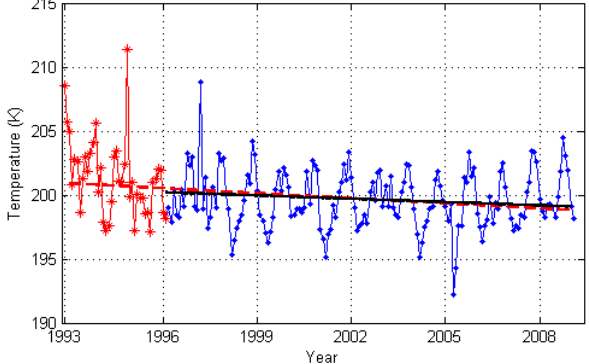
Figure 5: Time evolution of the monthly averaged temperature values in the lower 4 Fig. 5. Time evolution of the monthly averaged temperature values stratosphere (18-19 km) with the post-Pinatubo data (red star line) and the without post-5 in the lower stratosphere (18–19km) with the post-Pinatubo data Pinatubo data (blue line). The superimposed cooling trend line obtained with the post-6 (red star line) and the without post-Pinatubo data (blue line). The Pinatubo data (dash red line) and the cooling trend line obtained without the post-Pinatubo 7 superimposed cooling trend line obtained with the post-Pinatubo data (dash red line) and the cooling trend line obtained without the data (black line). 8 post-Pinatubo data (black